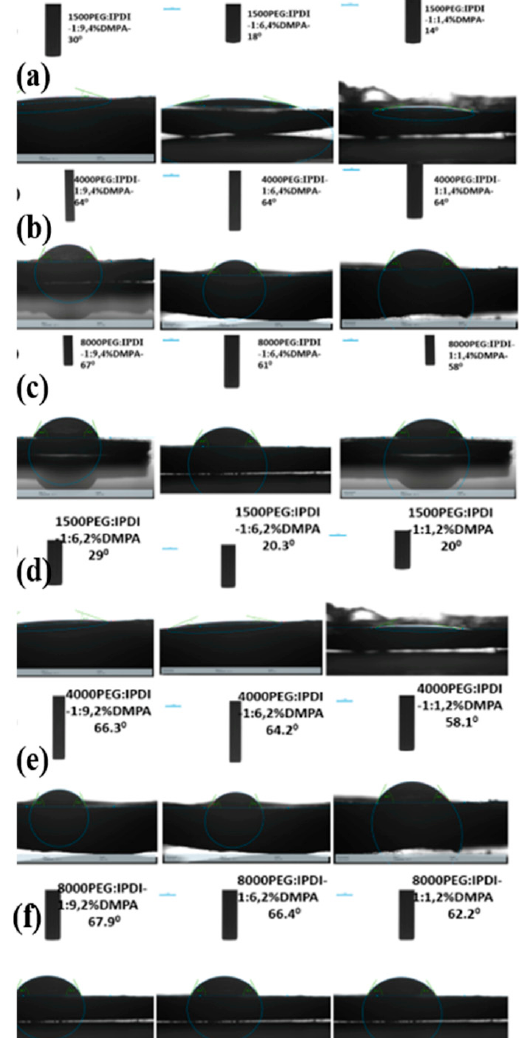
Figure 7. Contact angle of WSPU: ( a ) 1500 PEG: IPDI, 4% DMPA, ( b ) 4000 PEG: IPDI, 4% DMPA, ( c ) 8000 PEG: IPDI, 4% DMPA, ( d ) 1500 PEG: IPDI, 2% DMPA, ( e ) 4000 PEG: IPDI, 4% DMPA and ( f ) 8000 PEG: IPDI, 4% DMPA.